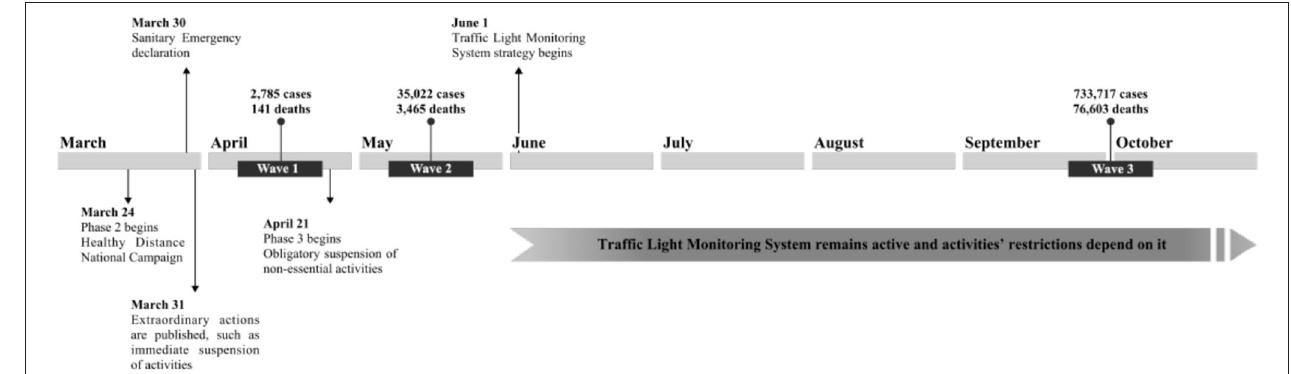
FIGURE 1 | Survey